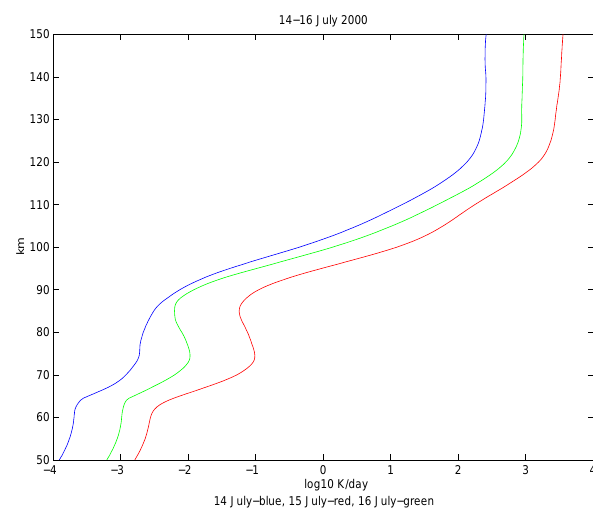
Fig. 7. Daily net Joule heating